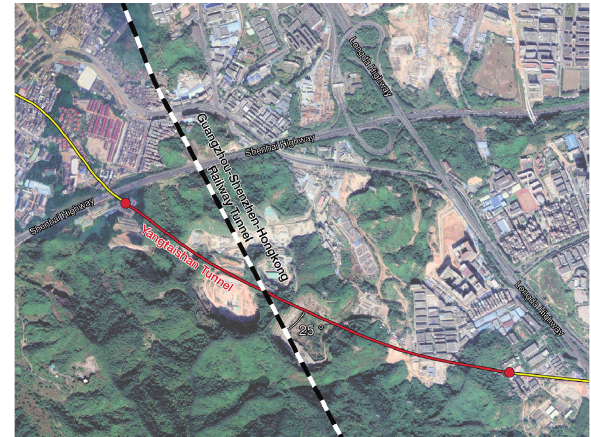
Figure 5: Plane position of the two